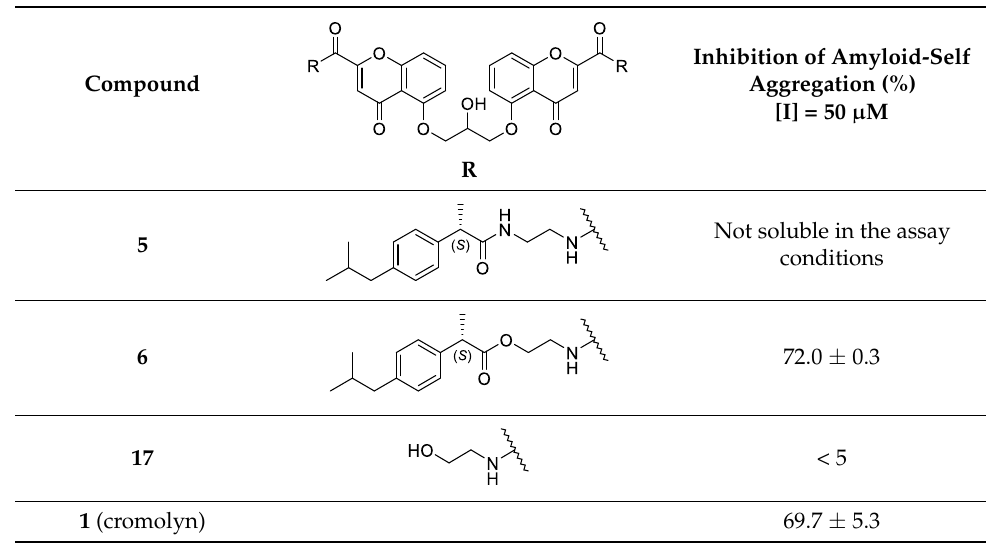
Table 2. Inhibition of Aβ 42 self-aggregation of conjugates 5 and 6.